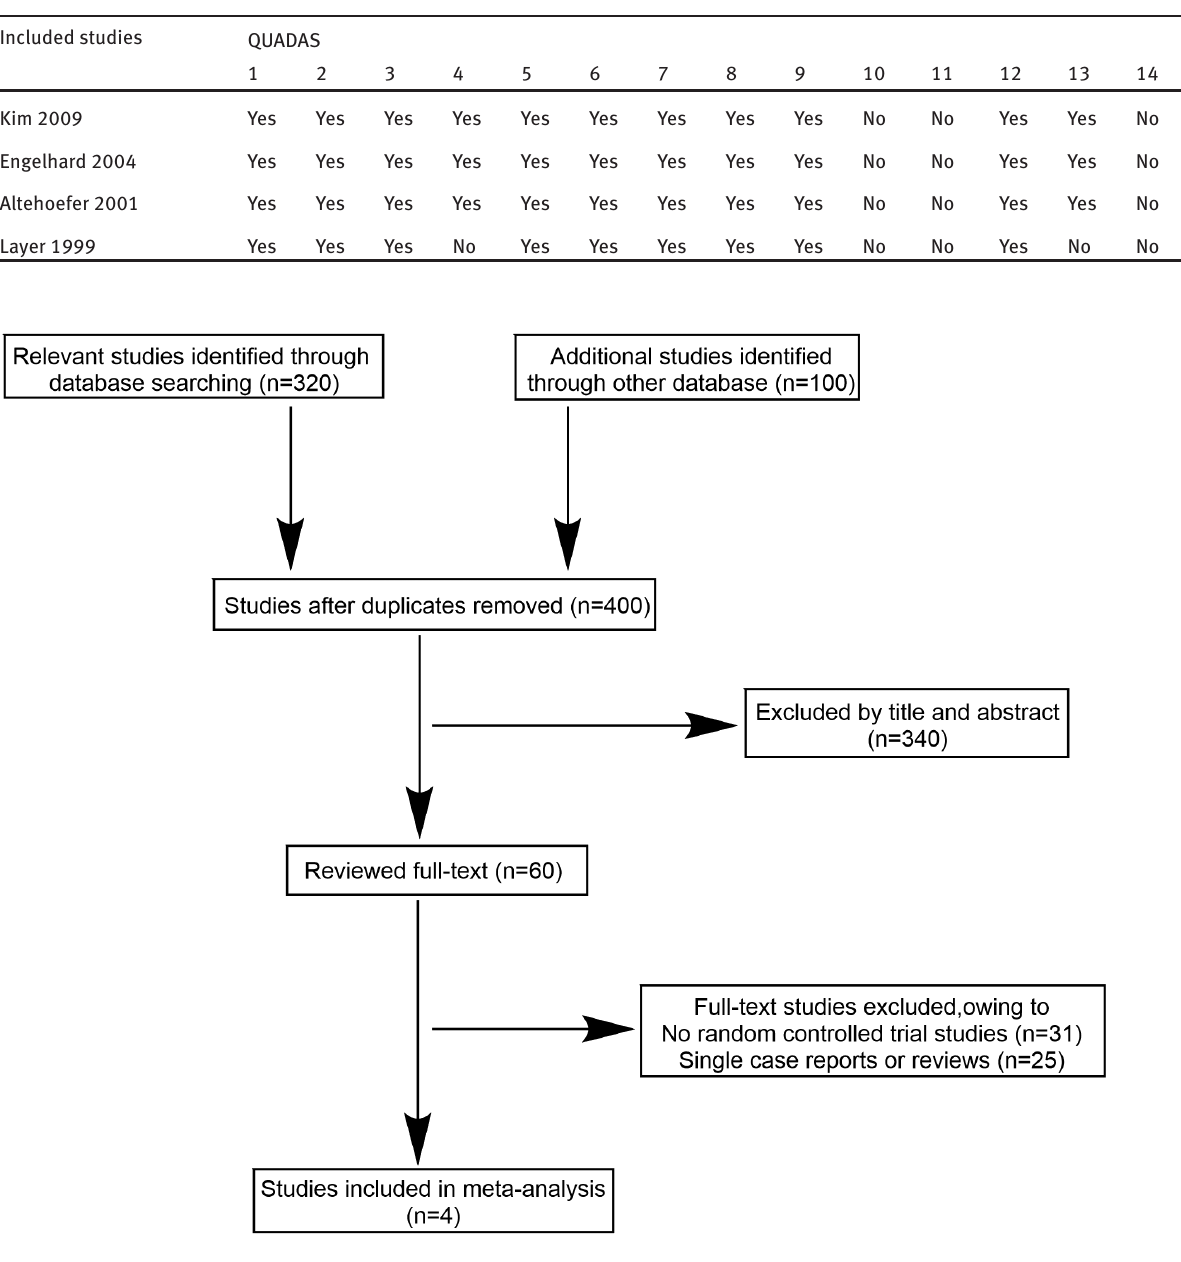
Figure 1: The study selection